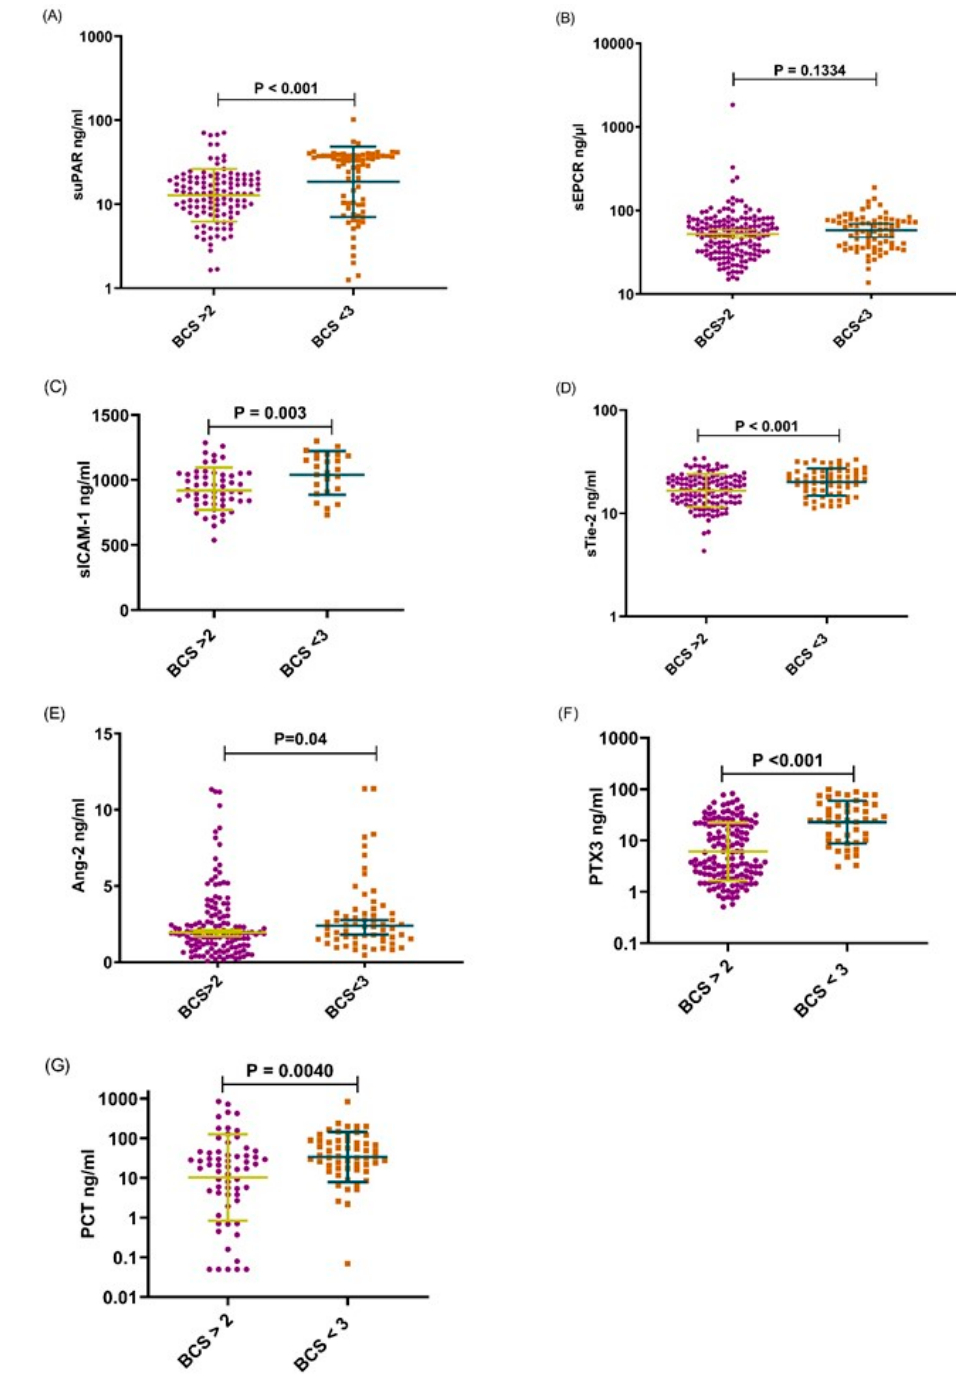
Figure 2. Plasma levels of suPAR, sEPCR, sICAM-1, sTie-2, Ang-2, PTX3 and PCT, in children with BCS < 3 compared to those with BCS > 2. ( A – G ), The levels of ( A ) suPAR, ( B ) sEPCR, ( C ) sICAM-1, ( D ) sTie-2, ( E ) Ang-2, ( F ) PTX3 and ( G ) PCT, in children with coma, i.e., with a BCS < 3 (brown squares) compared to those with a BCS > 2 (purple dots). The molecules were measured by ELISA on the day of admission to the hospital. Data are presented as dot plots with median and (95% CI). The Mann–Whitney U-test was performed for each comparison.